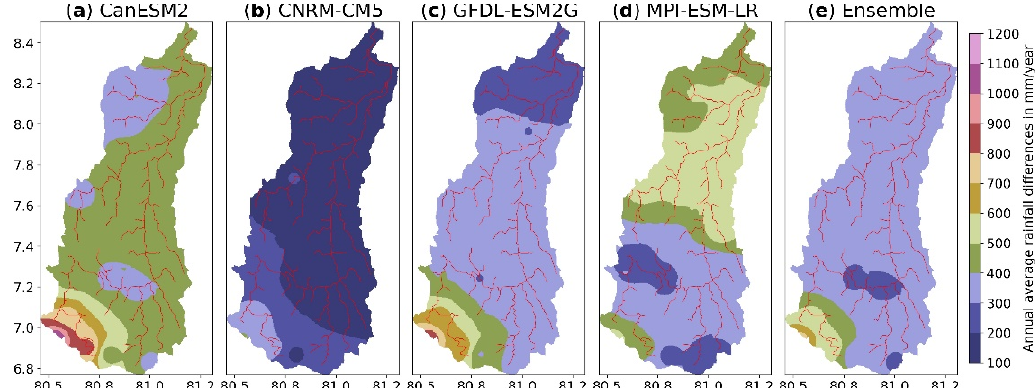
Figure 4. ( a ) The comparison of basin average annual rainfall (mm/year) between past and future climate and percentage changes (%) for each selected GCM; and ( b ) basin average seasonal rainfall differences (future—past) for selected GCMs and the ensemble mean.